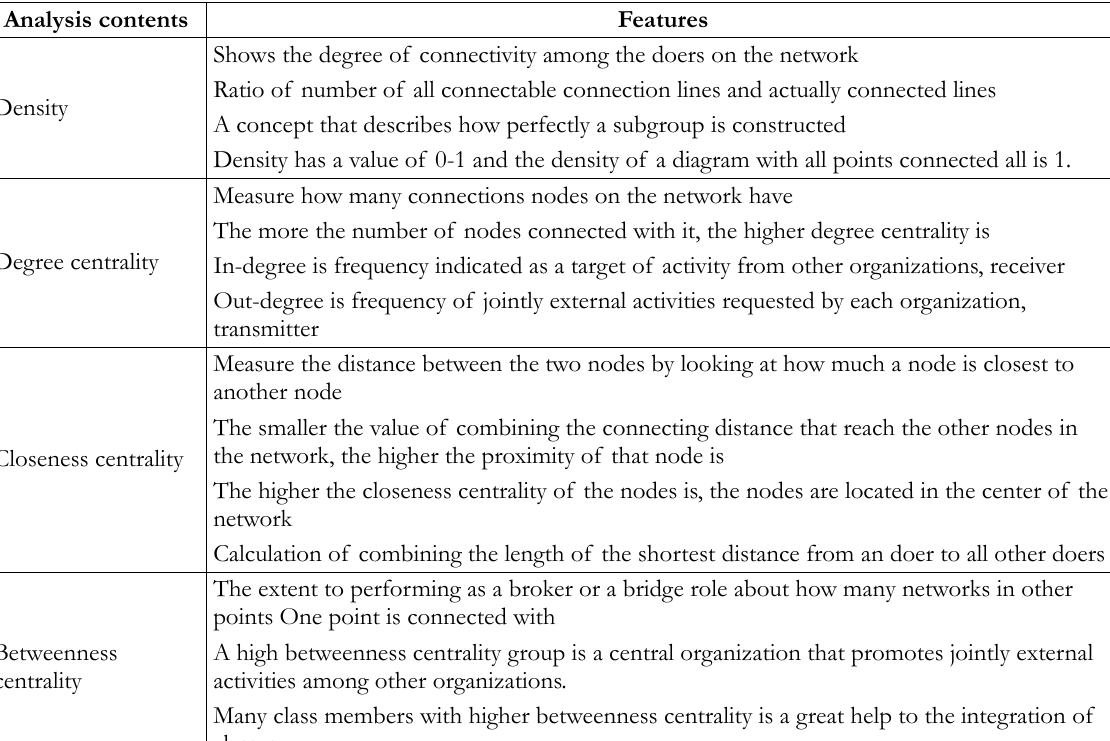
Table 3. Social Network Analysis Contents and